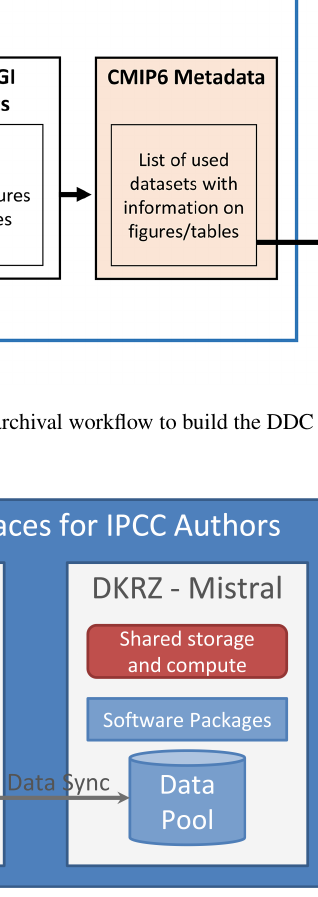
Figure 7. Virtual Workspaces provided by CEDA and the DKRZ for IPCC AR6 authors (co-funded by